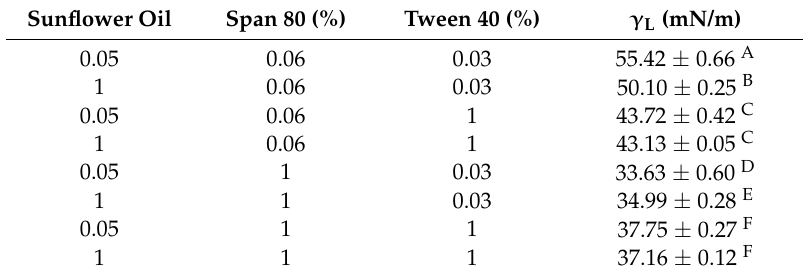
Table 2. Interaction effect of components on surface tension ( γ L ) values of coating solutions. Each formulation (each row) was incorporated into 1.25% sodium alginate + 2% glycerol solutions ( n = 3). Sunflower Oil Span 80 (%)